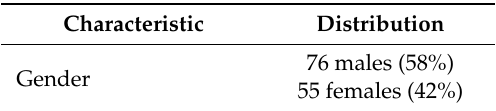
Table 1. Demographic characteristics of 131 veterinarians interviewed in the city of Medellin to a survey of pain recognition and control in dogs and